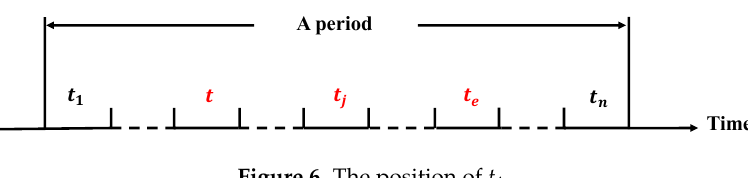
Figure 6. The position of t j